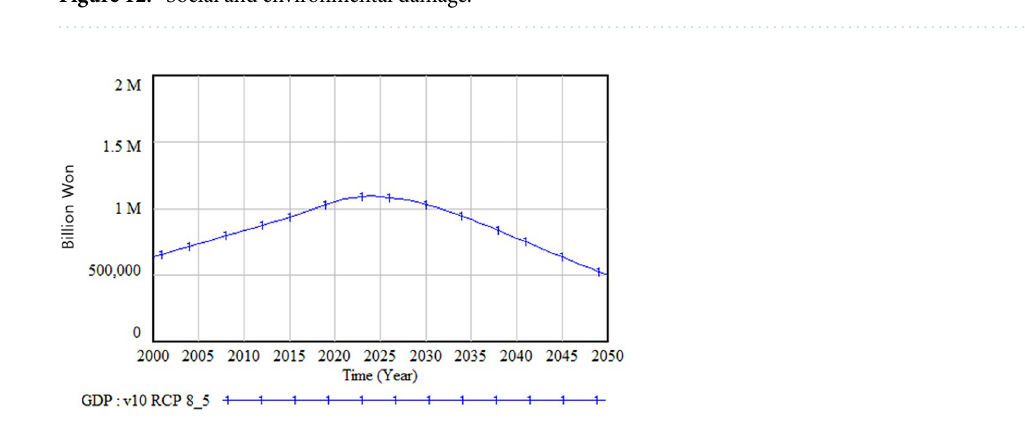
Figure 12. Social and environmental damage.